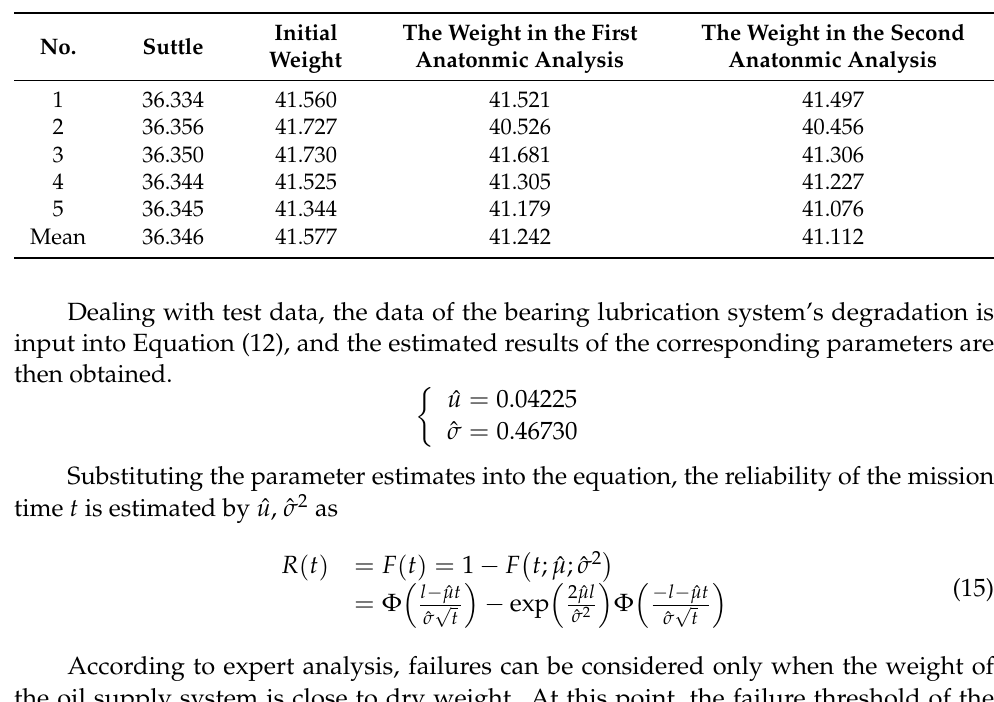
Table 2. Change in weight of bearing lubricant system.